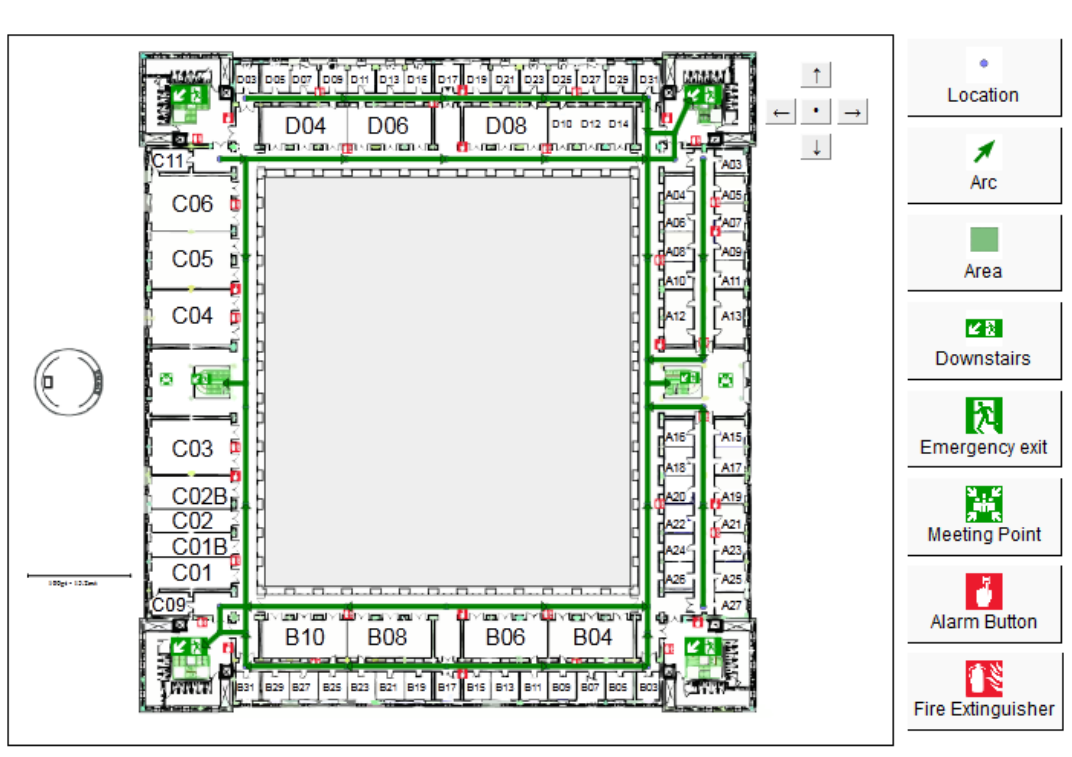
Figure 4. Definition of emergency evacuation routes in a particular